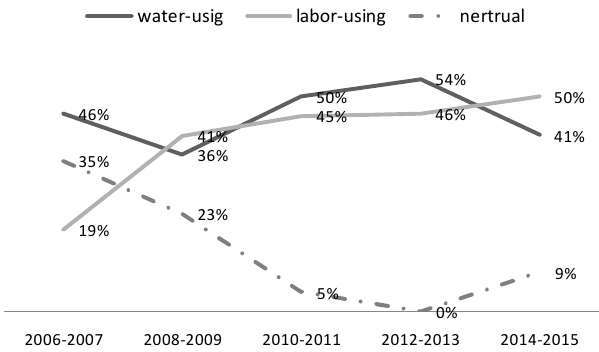
Figure 9. The dynamics of input-biased technical change as to the pair of water consumption and labor.